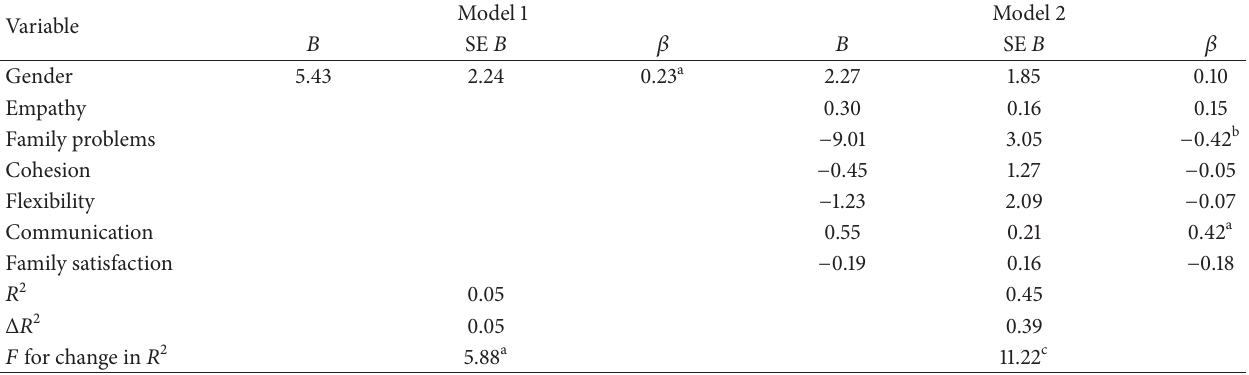
Table 4: Hierarchical multiple regression associations between caregiver income, family dynamics factors, and sense of coherence. Variable